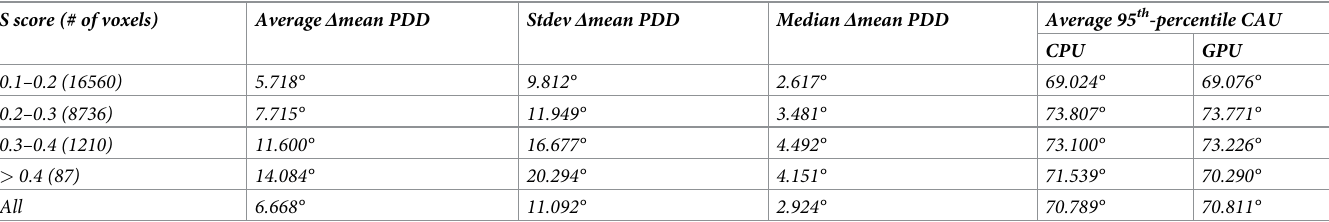
Table 6. Significantly different ϕ 2 , θ 2 in the